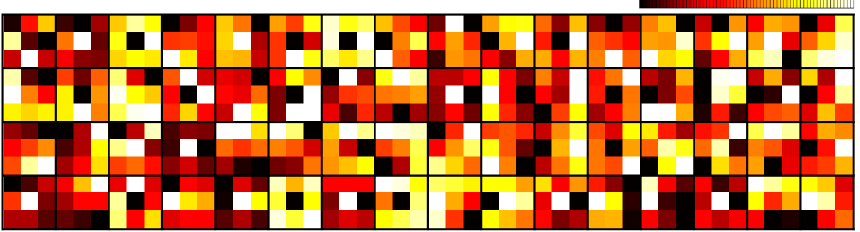
Figure 5. An example of convolution filter parameters that were obtained via our network training.